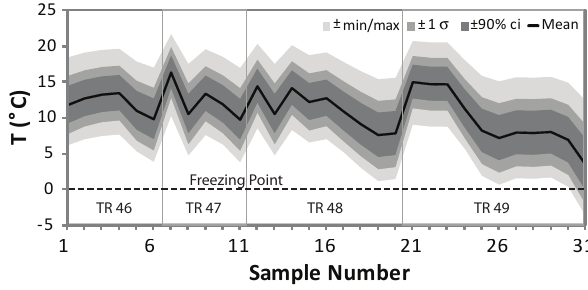
Figure 4. Mean temperature ( ◦ C) of subannual data based on all δ 18 O-temperature reconstructions. Mean of all reconstructions (black line) is bracketed by 90% confidence interval ( ± 90% ci, dark gray fill), one standard deviation ( ± 1 σ , medium gray fill), and minimum/maximum ( ± min/max, light gray fill). Freezing point is shown by dashed